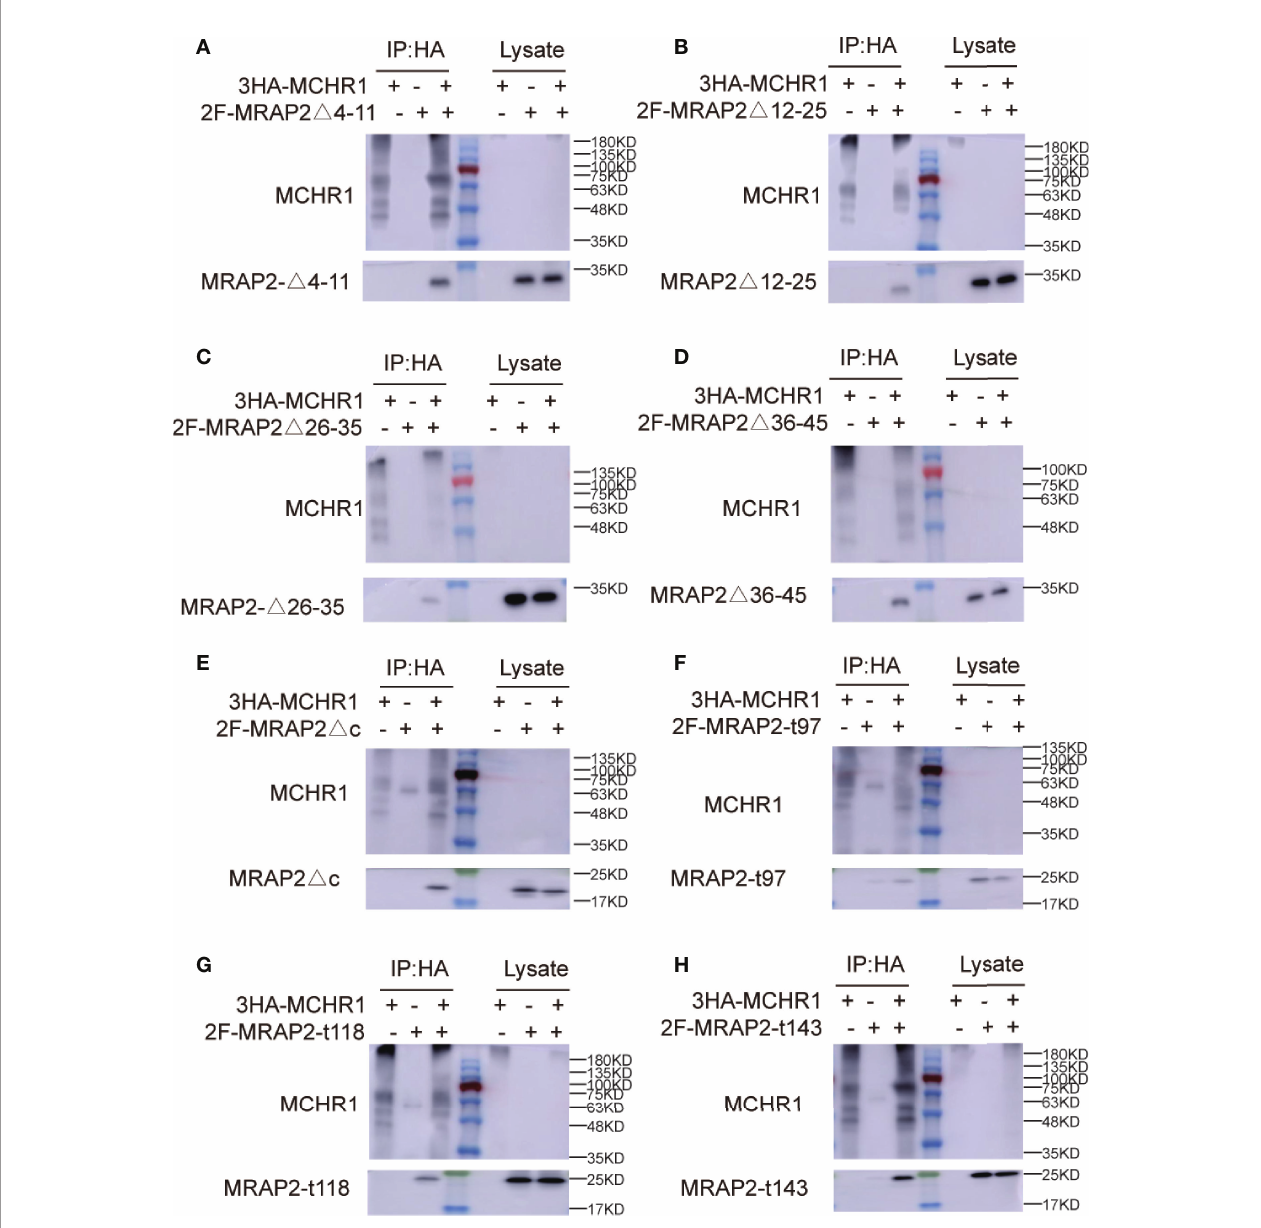
FIGURE 4 | Interaction between 3HA-MCHR1 and MRAP2 mutants. (A – D) The interaction between MCHR1 and MRAP2 C-terminal mutants. (E – H) The interaction between MCHR1 and MRAP2 N-terminal mutants. Middle lane with color is protein marker in all fi gures. The numbers on the right indicate molecular weight of marker band in the middle